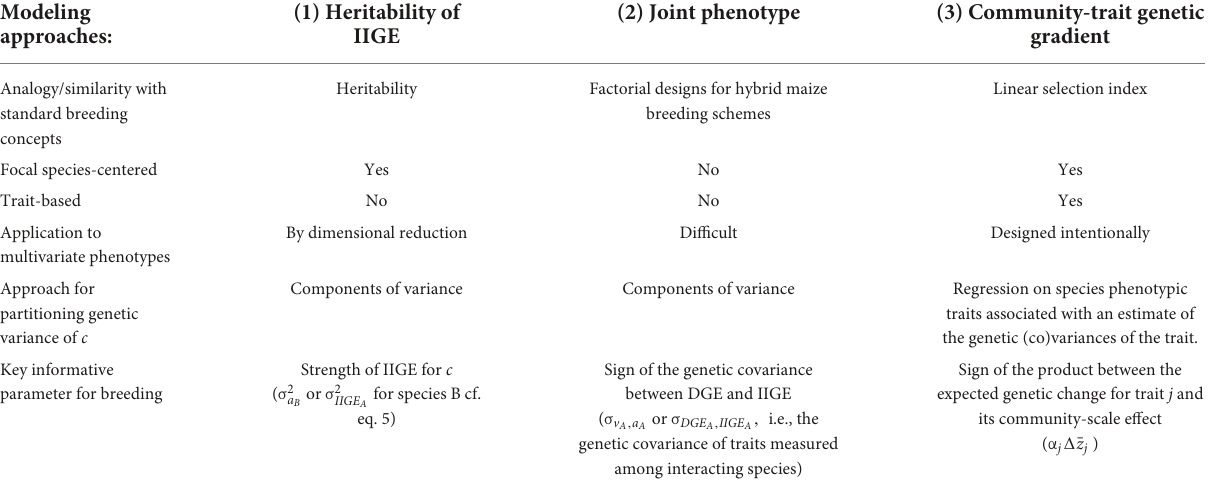
TABLE 1 Main features of the three modeling approaches described in the main text. Modeling